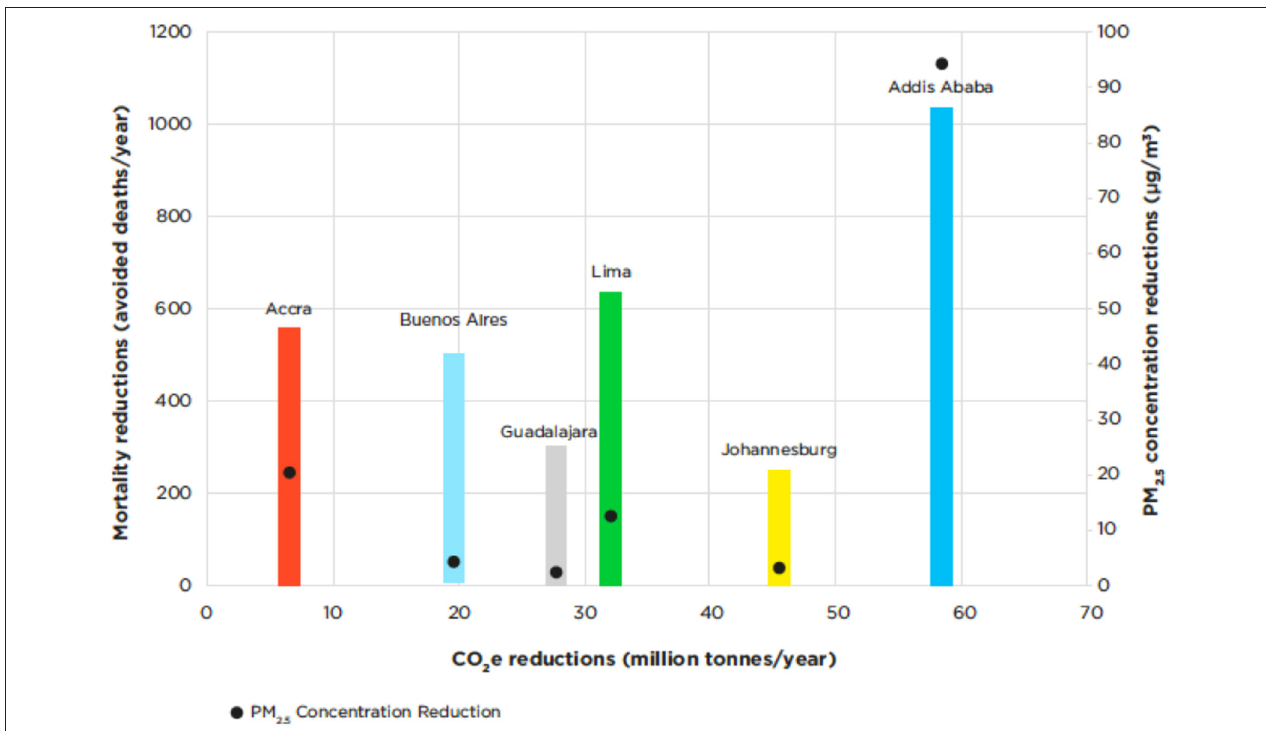
FIGURE 7 | City-specific estimated reductions in GHG emissions (CO 2 e), annual average PM 2.5 , and PM 2.5 -attributable mortality, for a given city’s “Ambitious” climate action